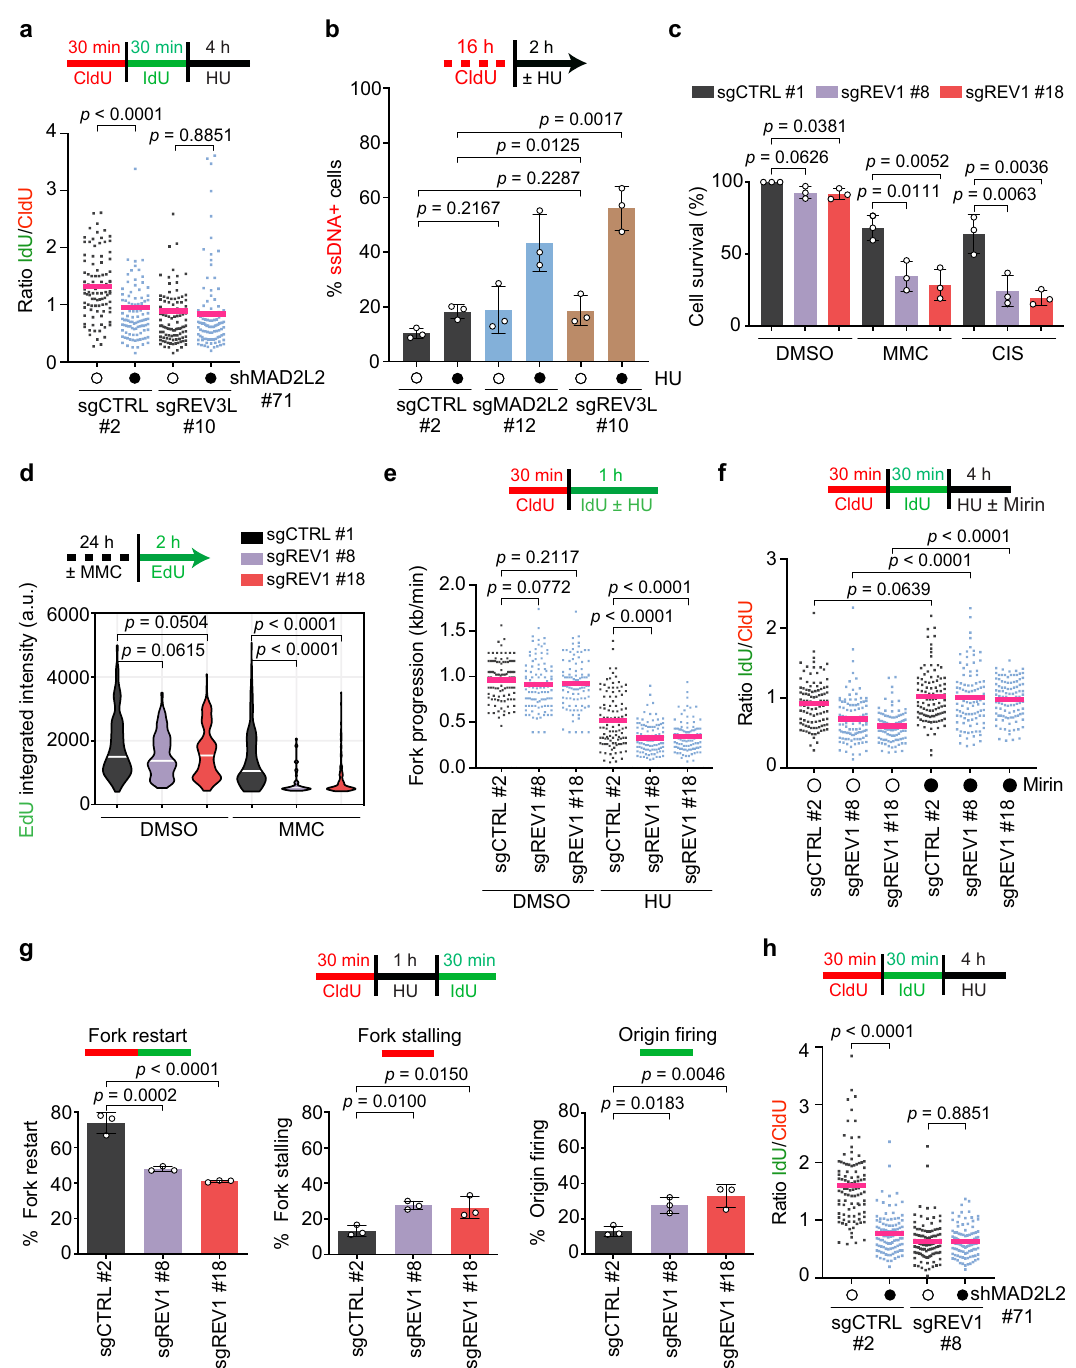
Fig. 6 | MAD2L2 activity at stressed replication forks prevents ssDNA accu- mulation and requires REV3L and REV1. a Schematic and quanti fi cation of fork degradationassaysincontrol(sgCTRL)andREV3L-depletedHeLacells,transduced with the indicated shRNAs and treated with 4mM HU for 4h. b Schematic and quanti fi cation of ssDNA-positive cells after CldU labeling for 16h, followed by mock treatment (open circles) or treatment with 4mM HU for 2h (closed circles). Bars represent the mean±SD of three independent experiments. c Quanti fi cation of survival assays in control and REV1-depleted HeLa cells, untreated or treated with 0.5 μΜ MMC or 1 μΜ CIS. Each dot represents one of three independent experiments. d Schematic and quanti fi cation of EdU incorporation intensity in control and REV1-depleted HeLa cells, untreated or treated with 5 μΜ MMC for 24h, followed by EdU labeling for 2h. White bars represent the median of three independent experiments. e Schematic and quanti fi cation of fork progression assaysincontrolandREV1-depletedHeLacells,untreatedortreatedwith4mMHU